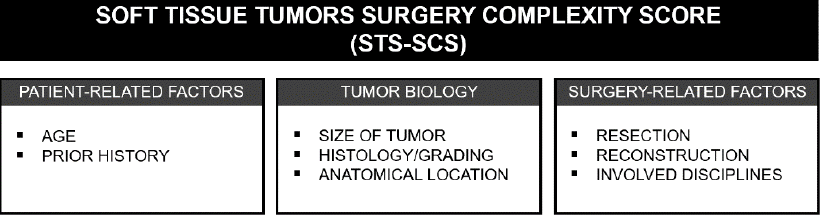
Figure 1. Overview of the three pillars and the individual factors on which the STS-SCS is based.